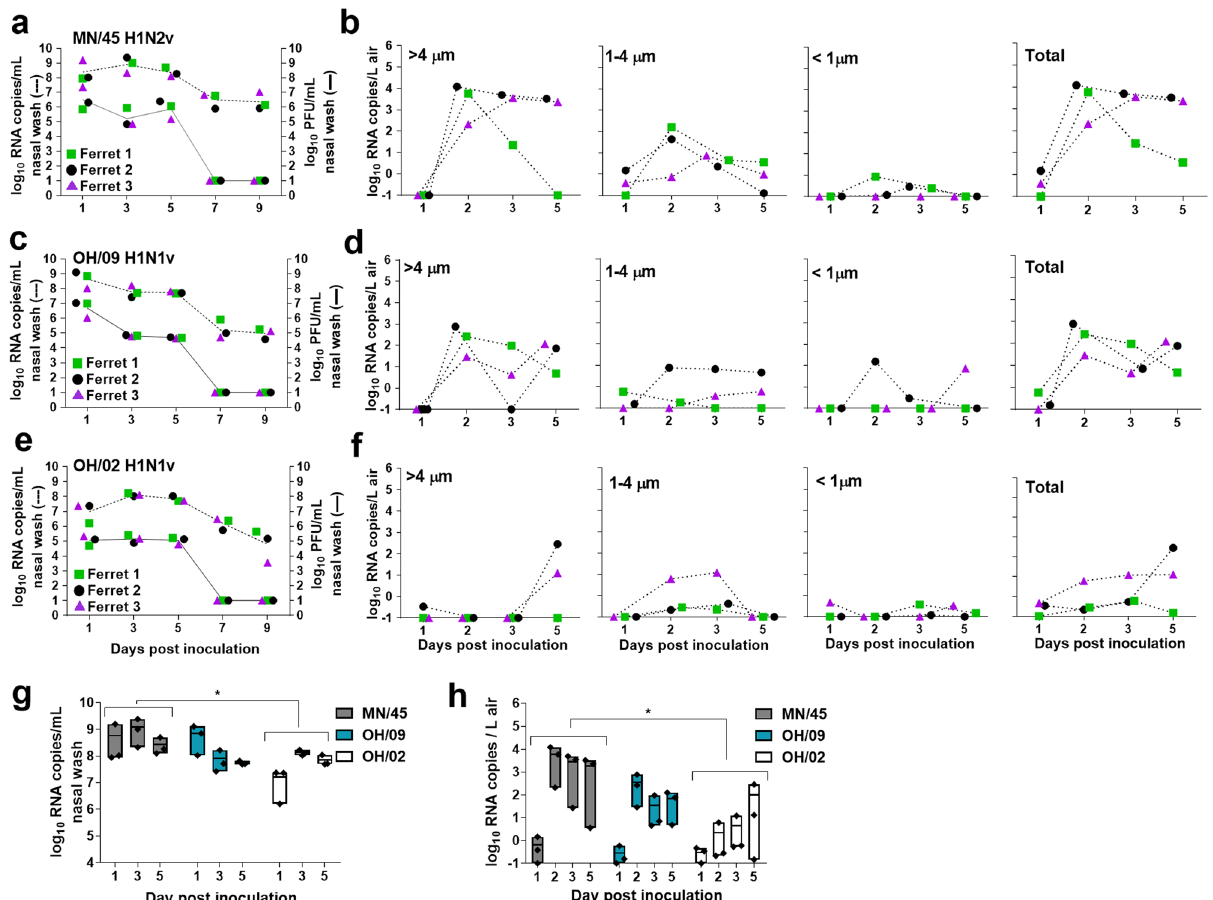
Fig. 1 In fl uenza A viral RNA measured in the air following inoculation of ferrets. Nasal wash specimens from ferrets ( n = 3 per virus) inoculated with A/Minnesota/45/2016 A(H1N2)v a , A/Ohio/09/2015 A(H1N1)v c , and A/Ohio/02/2007 A(H1N1)v e were collected on days 1, 3, 5, 7, 9 p.i. Infectious virus was quanti fi ed by standard plaque assay (solid lines) and viral RNA copies were quanti fi ed using real time qRT-PCR (dashed lines). Individual ferrets are shown as different symbols (ferret 1-green square, ferret 2-black circle, ferret 3-purple triangle). Limit of detection was 1 log 10 PFU/ml or RNA copies/ml of nasal wash. Air samples were collected from each ferret cage for 2 hours on indicated days using a two-stage cyclone sampler which fractioned particles by size: >4 µ m, 1 – 4 µ m, <1 µ m. Viral RNA in each sample was quanti fi ed using real time qRT-PCR and the data for each virus; A/Minnesota/45/2016 A(H1N2)v b , A/Ohio/09/2015 A(H1N1)v d , A/Ohio/02/2007 A(H1N1)v f , and individual ferret is shown. Limit of detection was 21 copies per 210 liters of air collected at each time point (0.1 RNA copy/L of air). Summary fi gures comparing viral RNA copies detected in the nasal wash specimens g and in the air h collected through day 5 p.i. The points on graphs are the data for individual ferrets, the bars represent minimum and maximum, and the lines represents the mean. Area under the curve for each of these time courses was calculated and statistical signi fi cance was evaluated using One-Way ANOVA (Tukey ’ s post-test [g]) and Kruskal-Wallis test (Dunn ’ s post-test [h]). * p < Quanti fi cation of airborne viral RNA following inoculation of ferrets with IAVs that poorly transmit . To further expand our analysis, we next evaluated a panel of viruses that do not transmit or poorly transmit in the ferret model. As reported elsewhere (Table 1), the highly pathogenic avian in fl uenza (HPAI) A/ Yunnan/14563/2015 (Yunnan/14563) A(H5N6) virus did not transmit between co-housed ferrets, while the LPAI A/turkey/ California/18-031151-4/2018 (tr/CA/18-031151-4) A(H7N3) and viruses transmitted between 1/3 co-housed contact animals 29,30 . To investigate if reduced shedding of airborne viral RNA early after infection coincided with the lack of robust transmission among ferrets, we collected air from inoculated ferrets on days 1-3 p.i. (the period identi fi ed as most critical for transmission, Fig. 2). Out of the four viruses tested, ferrets inoculated with tr/CA/18- 031151-4 virus displayed the lowest nasal wash RNA titers (5.9 log 10 copies/mL) and released negligible levels of viral RNA into